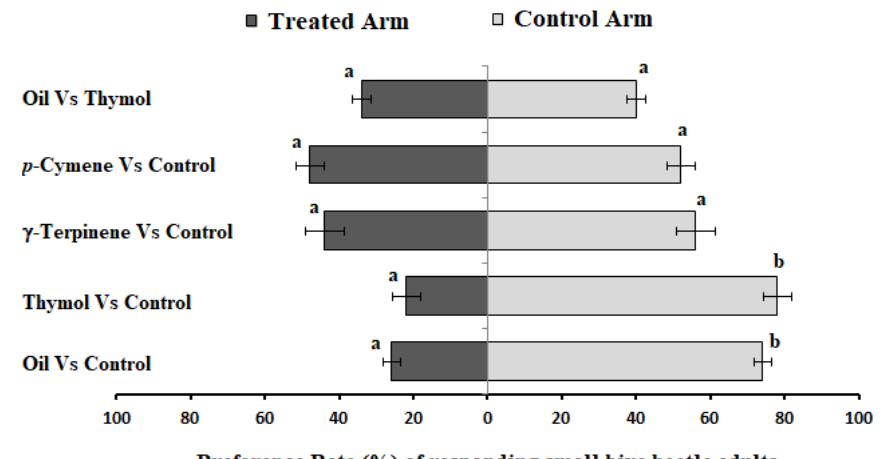
Figure 1. Response of the small hive beetle test in Y-tube olfactometer in dual choice b/n treatments and the control. N = 50 for all treatment. Note: The same letter in each test pair indicates no significance difference ( p > 0.05), and different letters in the pair of test means there is a significance difference. Table 2. Lethal dose (LD 50 ) and 95% confidence limits (CL) estimated for the small hive beetles 24 h after topical application of T. ammi essential oil and its three main constituents.